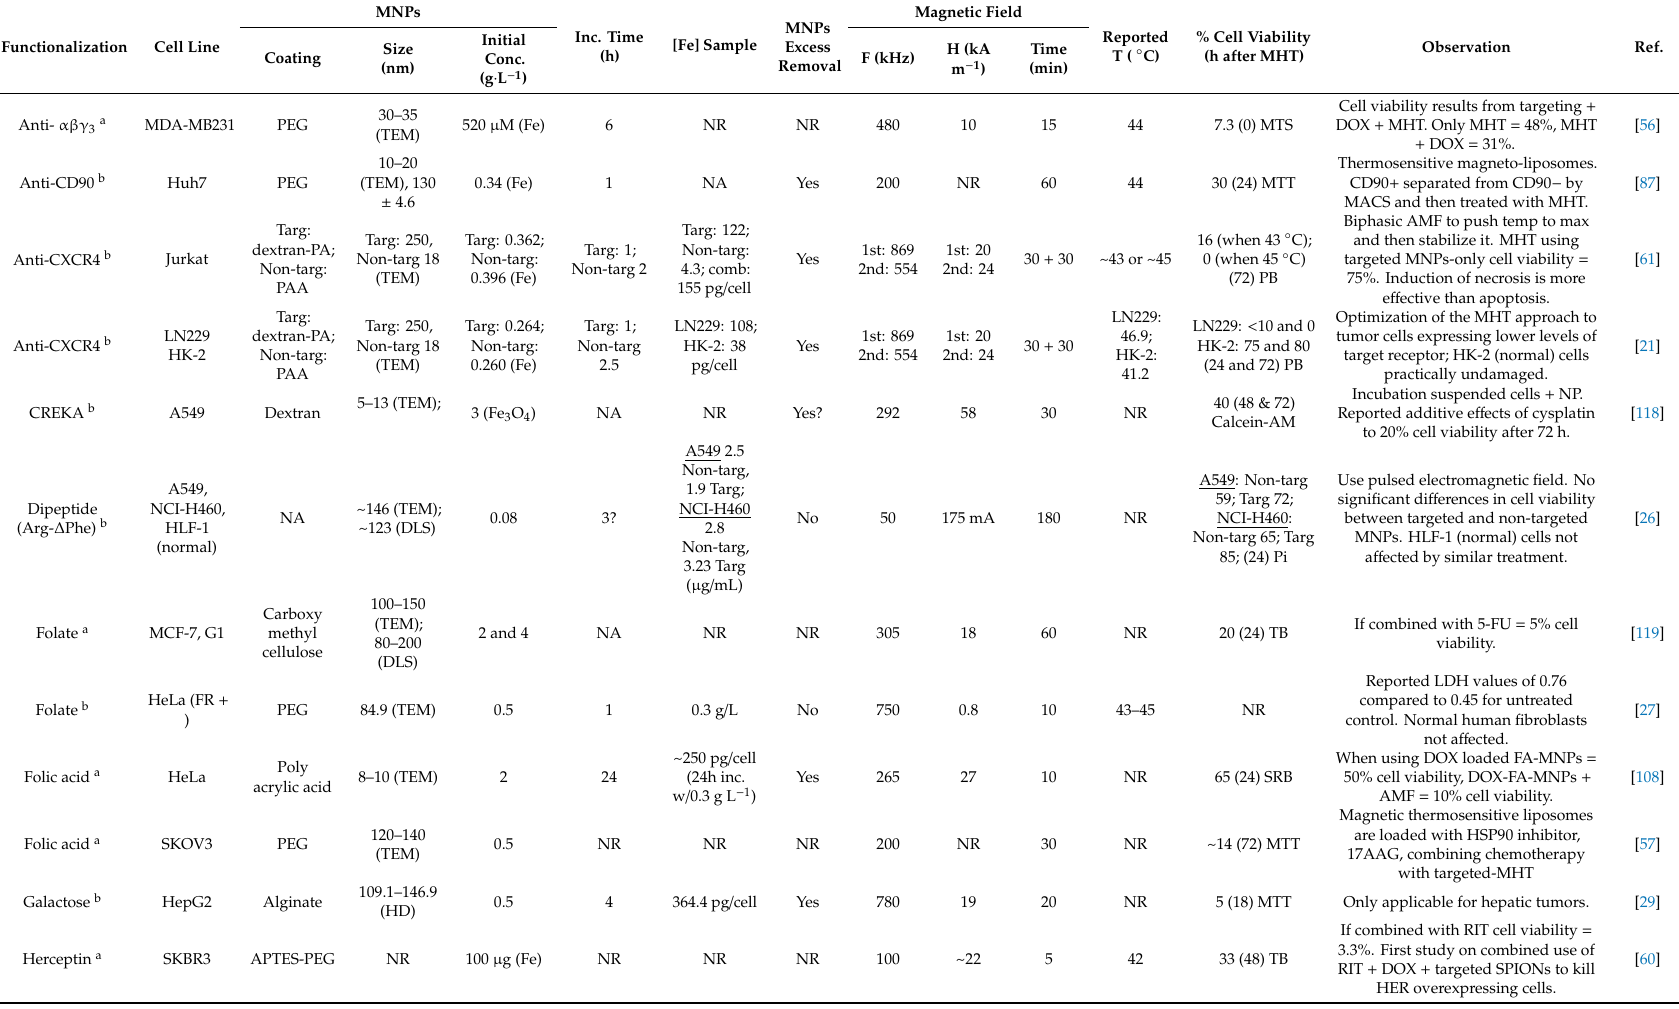
Table A2. Conditions used, and outcome observed, in in vitro studies using targeted MHT alone or combined with chemotherapeutic agents.